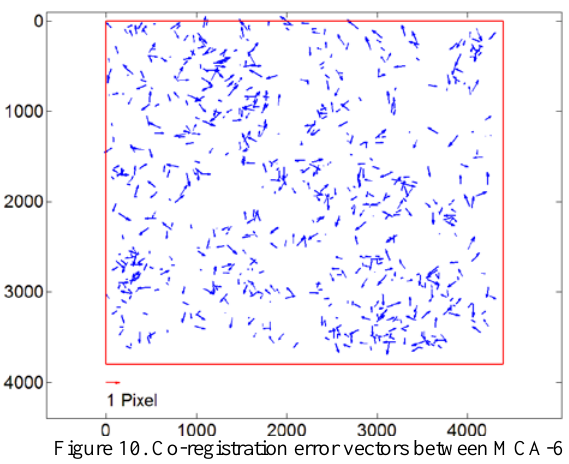
Figure 10. Co-registration error vectors between MCA-6 and Canon RGB